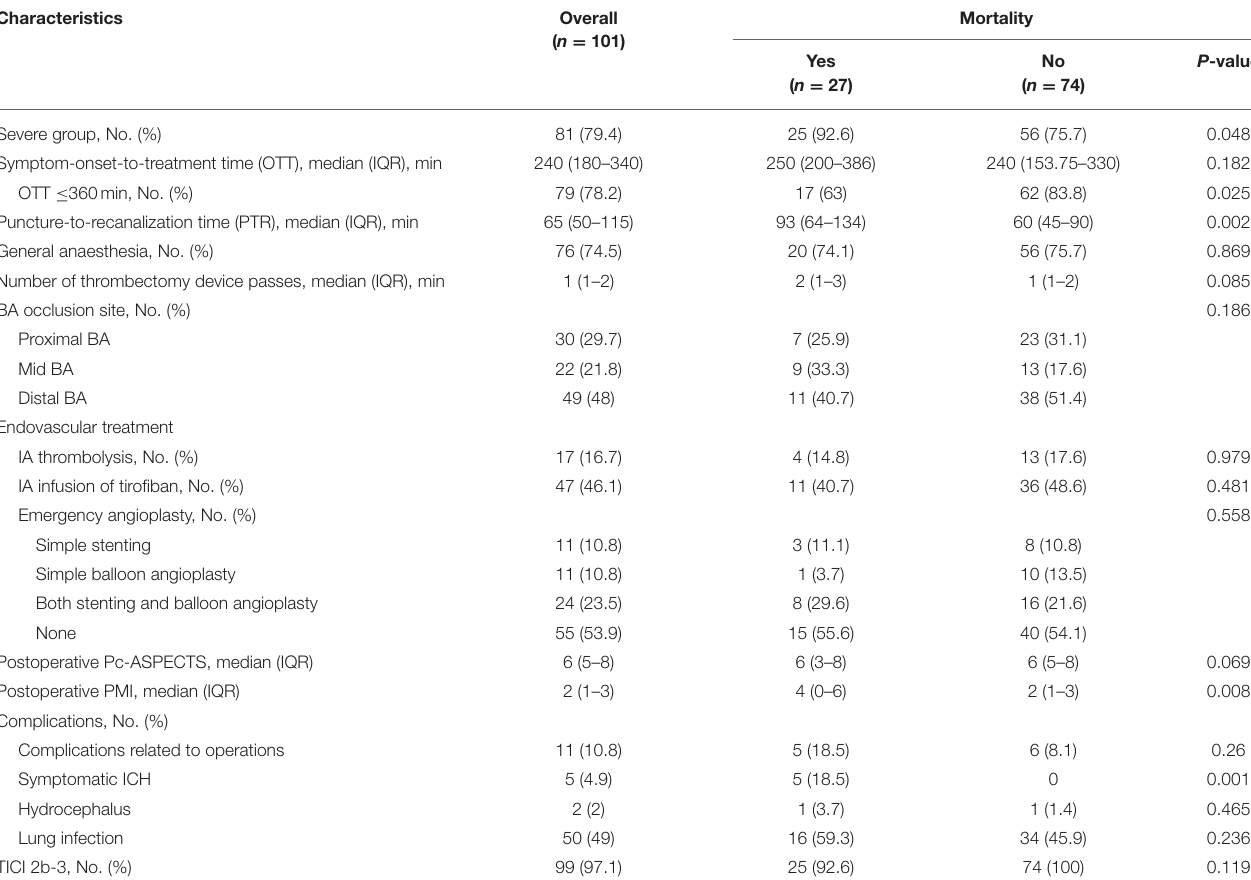
TABLE 4 | Periprocedural characteristics and mortality.